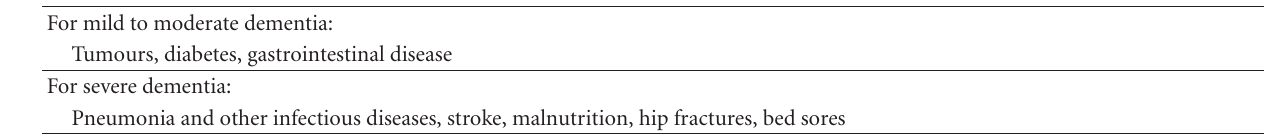
Table 2: Principal pathologies associated with patients with